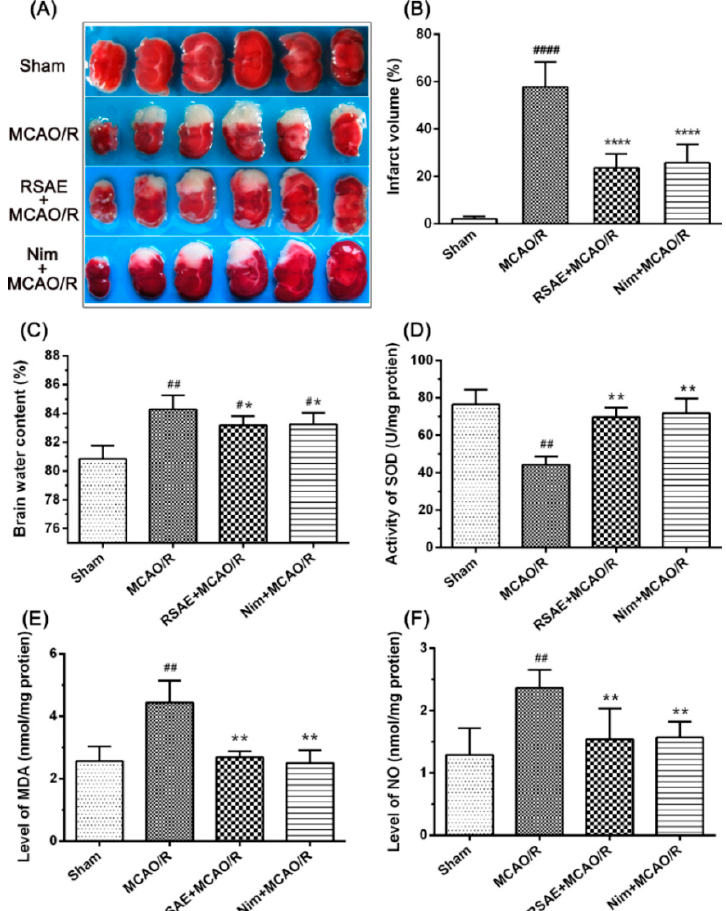
Figure 5. Effects of RSAE on infarct volume, brain water content, MDA, and NO concentrations and SOD activity in mice exposed to MCAO/R injury. RSAE reduced the infarct volume and brain water content (BWC). ( A ) Representative images of TTC-stained brain sections from the sham-operated or RSAE-treated animals collected 24 h after infarction. ( B ) Quantitative analysis of the infarct volume. ( C ) Brain water content in ischemia hemispheres of all groups. ( D ) The activity of SOD in ischemic hemispheres of all groups. ( E ) The concentration of MDA in ischemic hemispheres of all groups. ( F ) The concentration of NO in ischemic hemispheres of all groups. Mean values ± standard error of the mean (n = 10); * p < 0.05, ** p < 0.01, **** p < 0.0001 versus MCAO/R group; # p < 0.05, ## p < 0.01, #### p < 0.0001 versus sham-operated group.